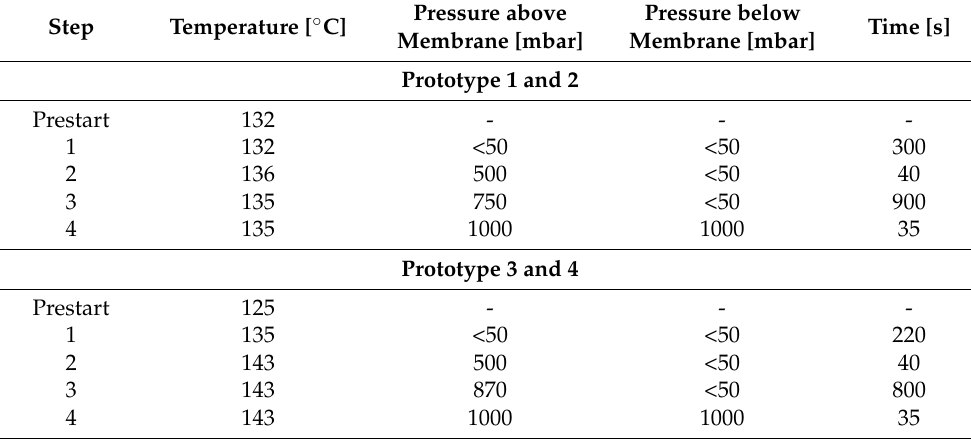
Table 2. Sequence of lamination process.